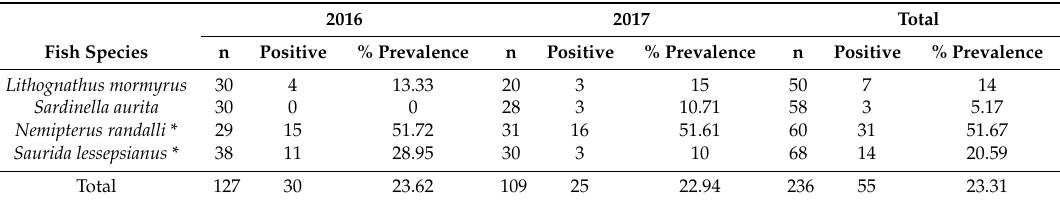
Table 2. Results of 2016 and 2017 surveys for NNV prevalence in wild fish species from the Mediterranean Sea. Results based on PCR targeting RNA1 and RNA2 segments. No significant difference was found between the same species in the consecutive years (Chi-Square test of independence, p > 0.05).